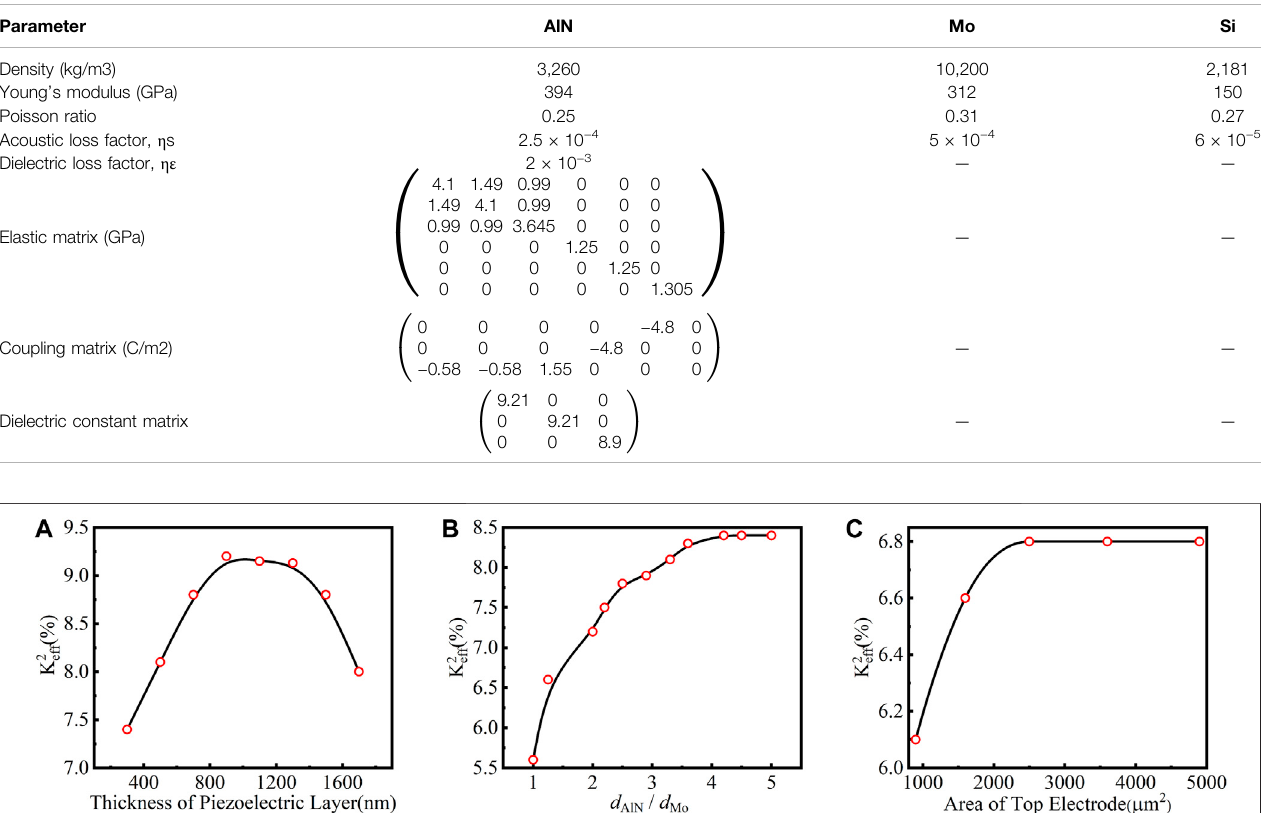
TABLE 1 | Simulation parameters for the fi lm of the FBAR. Parameter